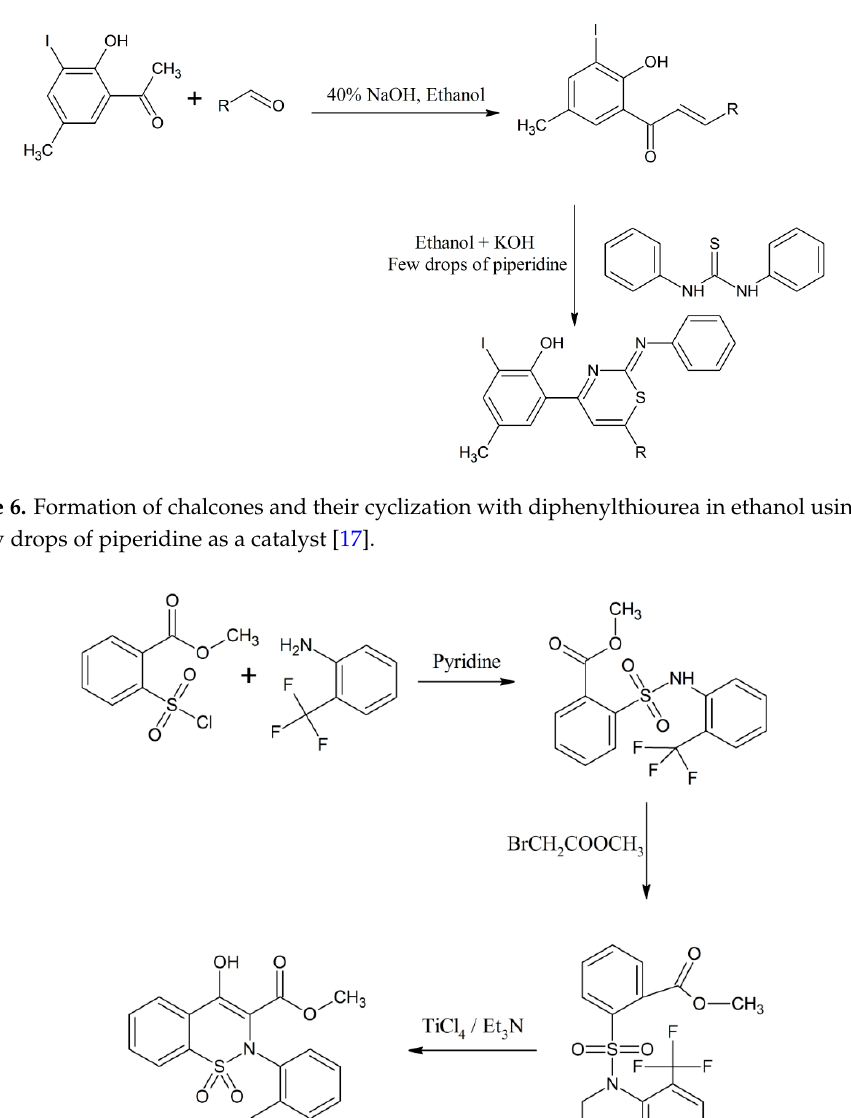
Molecules 2016 , 21 , 1054 4 of 19 Scheme 4. Synthesis of 1,3-thiazine derivatives under microwave irradiation [13]. Zia-ur-Rehman et al. synthesized a series of analogues of 4-hydroxy- N- (benzylidene)-2 H -benzo [ e ][1,2]thiazine-3 carbohydrazide 1,1-dioxides [14]. They performed N -alkylaton of sodium saccharin with methyl chloroacetate in the presence of ultrasonic irradiation [14]. Both the reagents were dissolved in dimethyformamide for the ultrasonic irradiation. The advantage of this process is that it can be done at lower temperatures and in a short period of time. In the next stage, the five membered isothiazole ring was converted into the thiazine ring under inert atmosphere conditions and then treated with hydrazine which was followed by reaction with benzaldehydes to give the desired products in high yield (Scheme 5) [14]. Some of the derivatives have good antibacterial properties, while most of the products possess antioxidant activities. Recently the same research group has expanded the synthesis of these 1,2-benzothiazine-3-carbohydrazide 1,1-dioxides using a microwave-assisted method that gives the products in high yield [15]. Zia-ur-Rehman et al. have also performed crystallographic studies of the 1,2-benzothiazine compounds to get better information about their molecular structure in terms of bond lengths, bond angles and various possible conformational states [16]. Scheme 5. General Scheme for the synthesis of different N -[(1 E )-arylmethylidene]-4-hydroxy 2 H -1,2- benzothiazine-3-carbohydrazide 1,1-dioxides derivatives [14]. Dighade et al. synthesized different chalcones through a condensation process of 2-hydroxy-3-